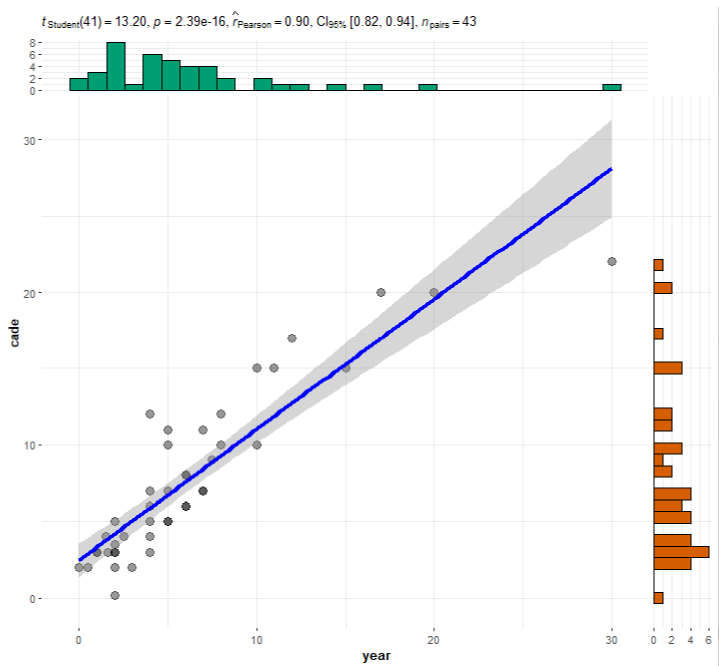
Figure 2. Correlation coefficients and correlation tests between CAD experience (cade) and total AEC experience (year).